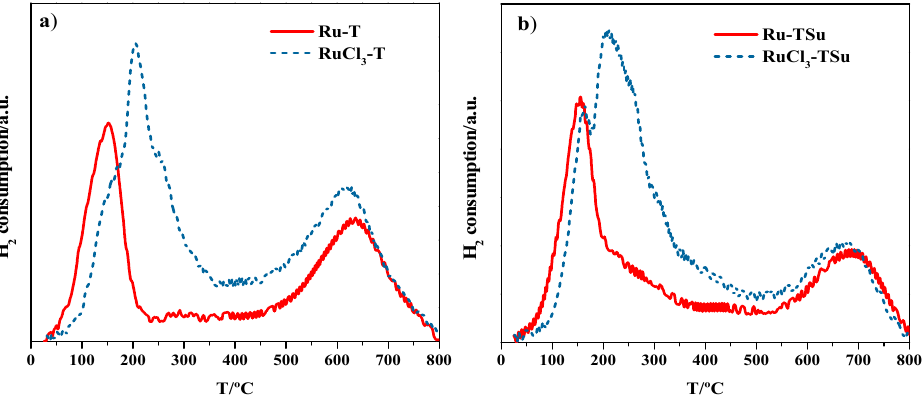
Figure 3. Temperature programmed reduction (TPR) profiles of samples ( a ) RuCl 3 -T and Ru-T and ( b ) RuCl 3 -TSu and Ru-TSu.